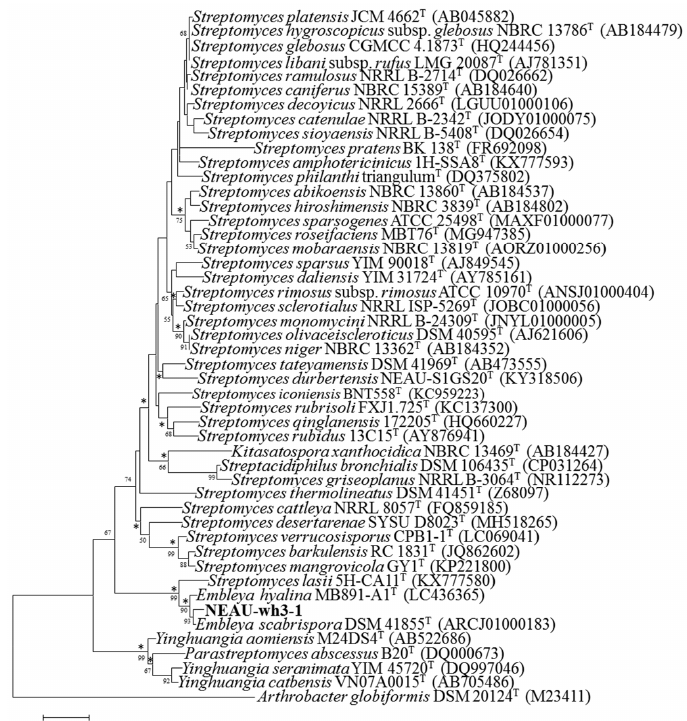
algorithm ( Streptomyces lasii 5H-CA11 T lacks housekeeping genes; Supplementary Figure S3). Moreover, pairwise distances calculated for NEAU-wh3-1 and the related species using concatenated sequences of atp D- gyr B- rec A- rpo B- trp B were well above 0.007 (Table S2) for the related species, which was considered to be the threshold for species determination [74].